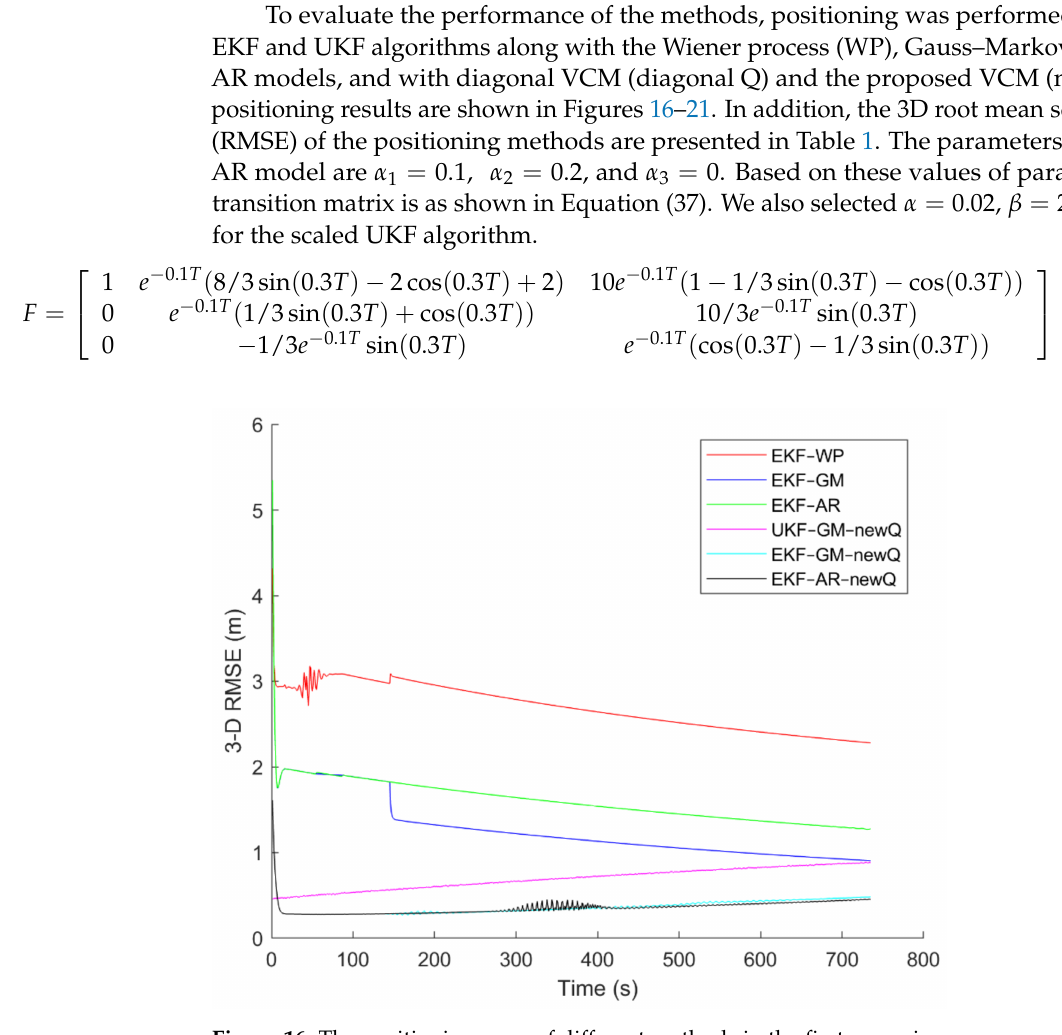
Figure 16. The positioning error of different methods in the first scenario.